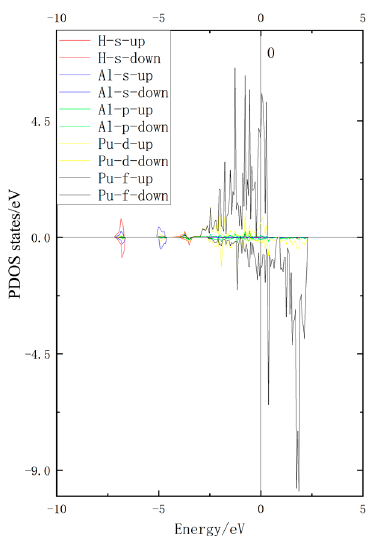
Figure 10. PDOS of Pu-Al system (near the Fermi level).